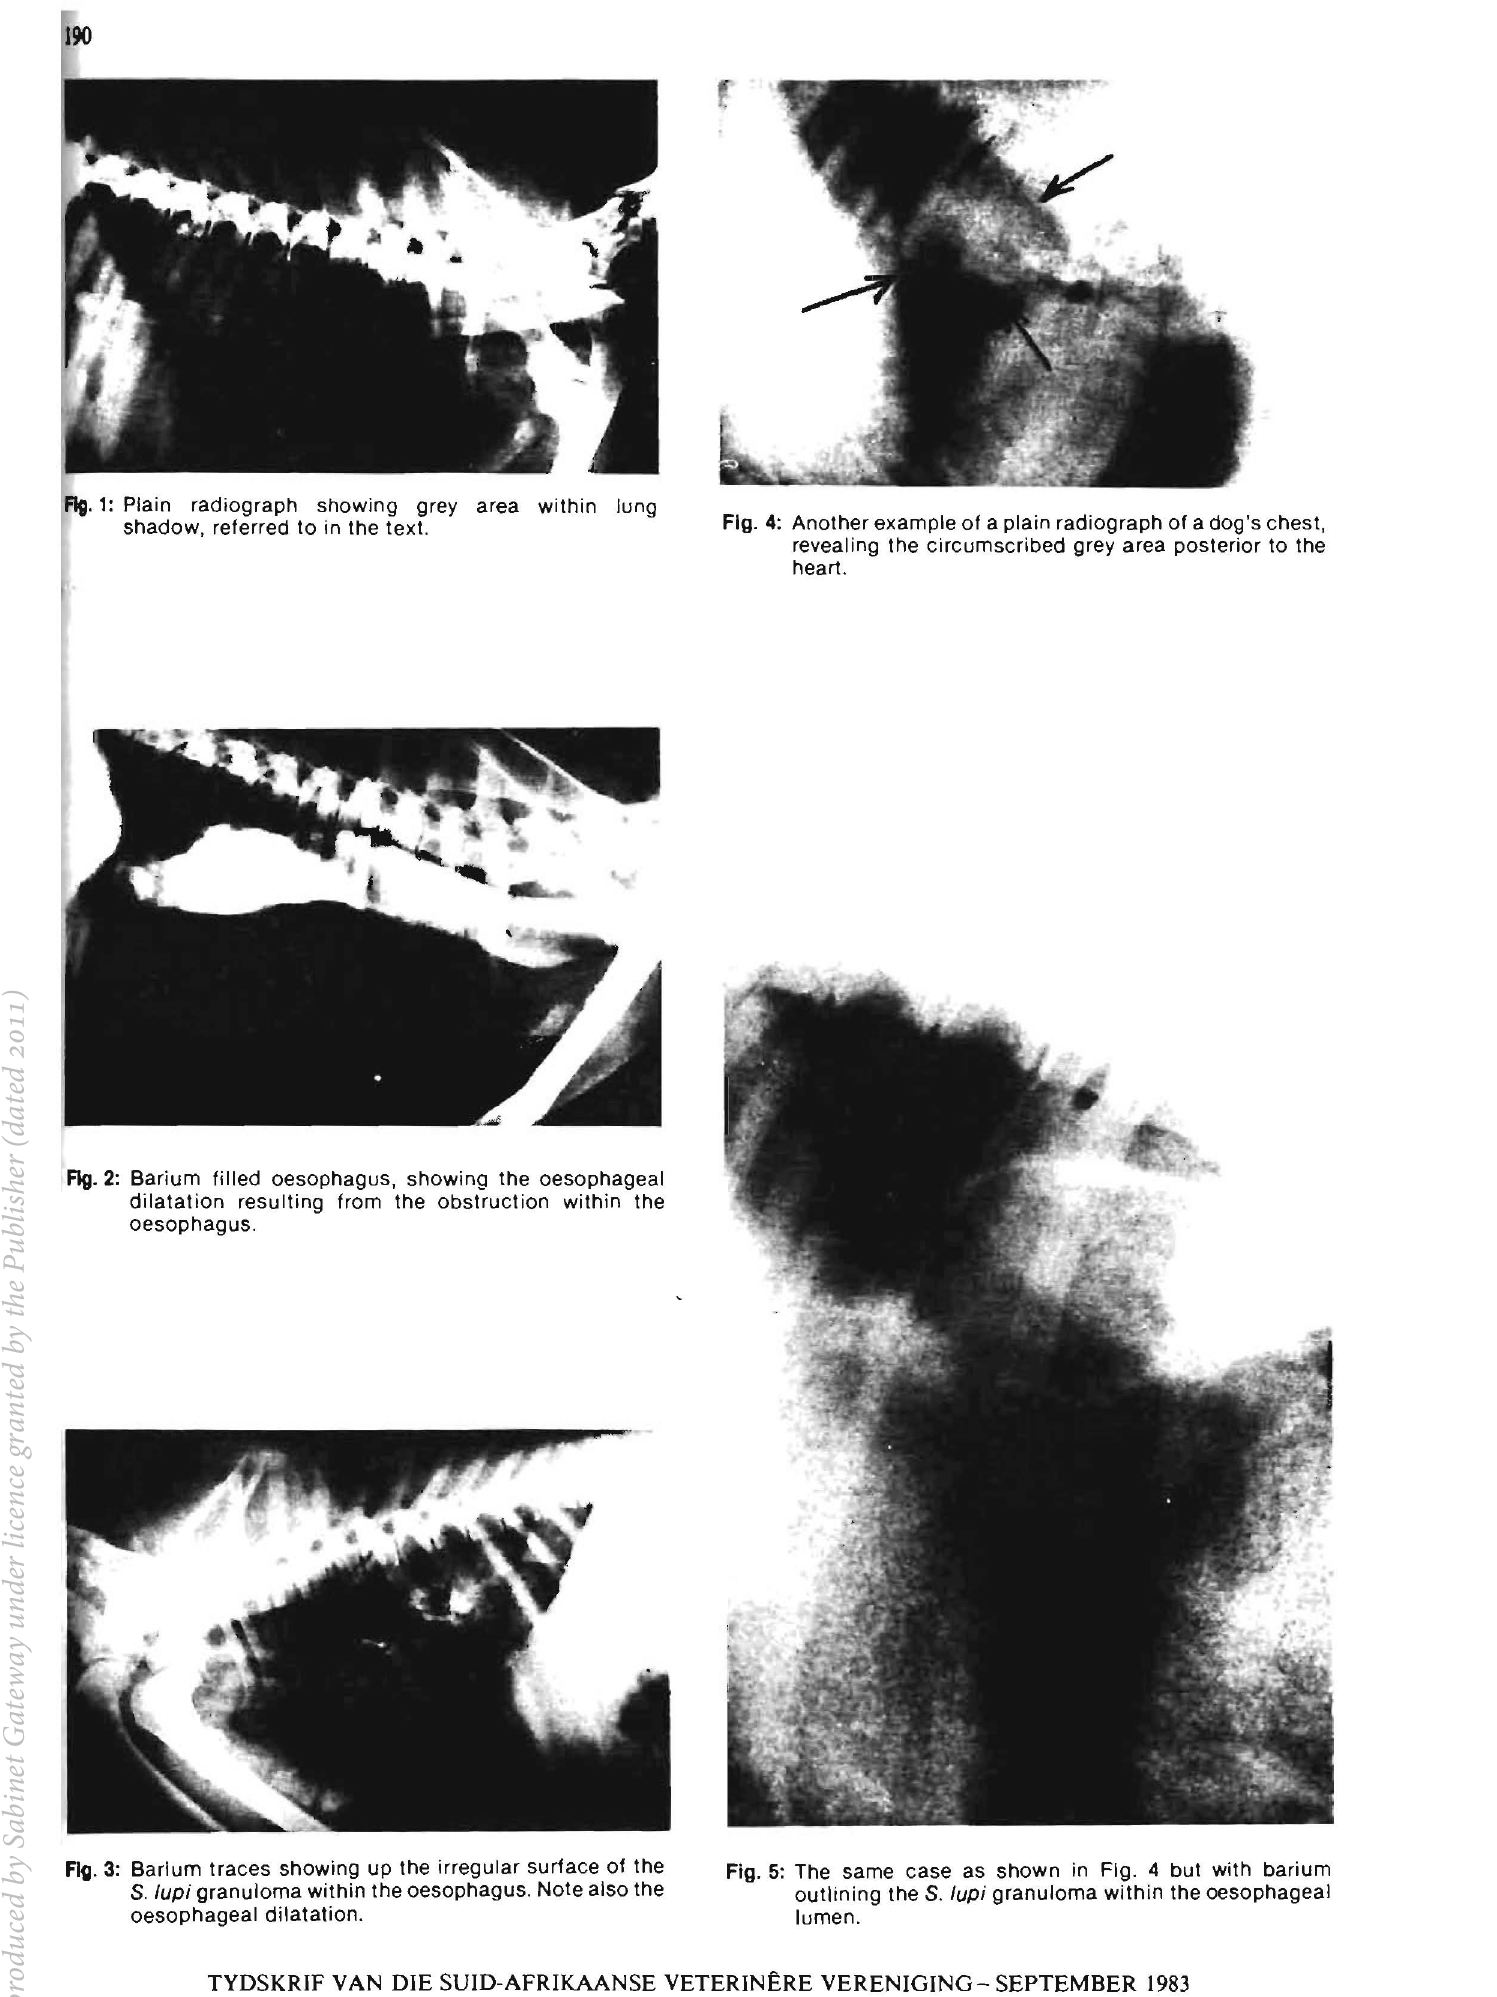
Fig. 5: The same case as shown in Fig. 4 but with barium outlining the S. lupi granuloma within the oesophageal